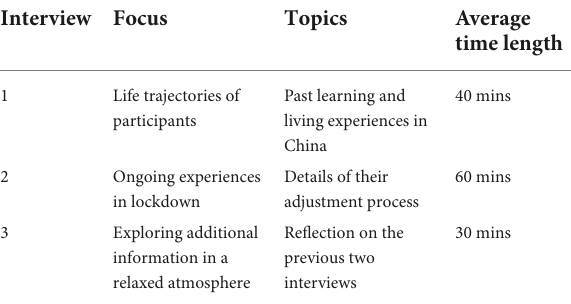
TABLE 2 Phases and topics of semi-structured